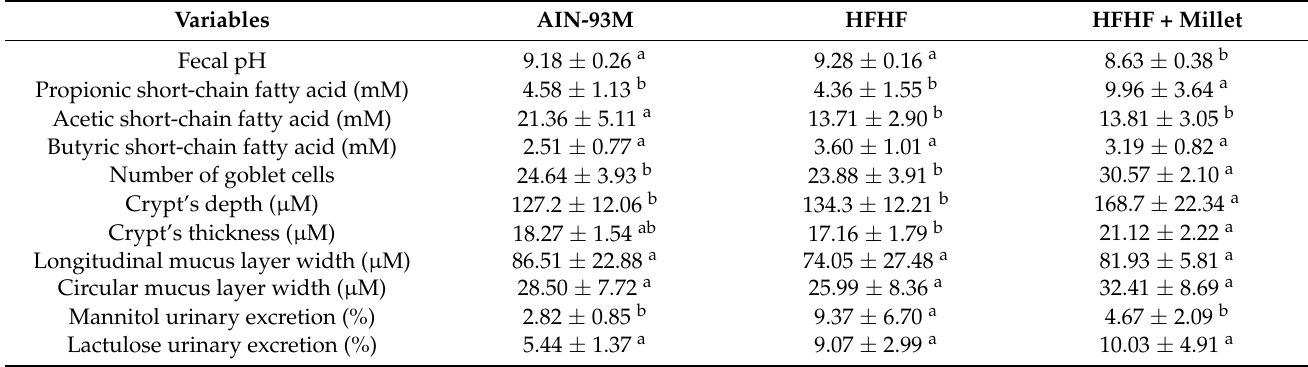
Table 1. Effects of germinated millet flour intake for 10 weeks on intestinal health in Wistar rats (n = 8).